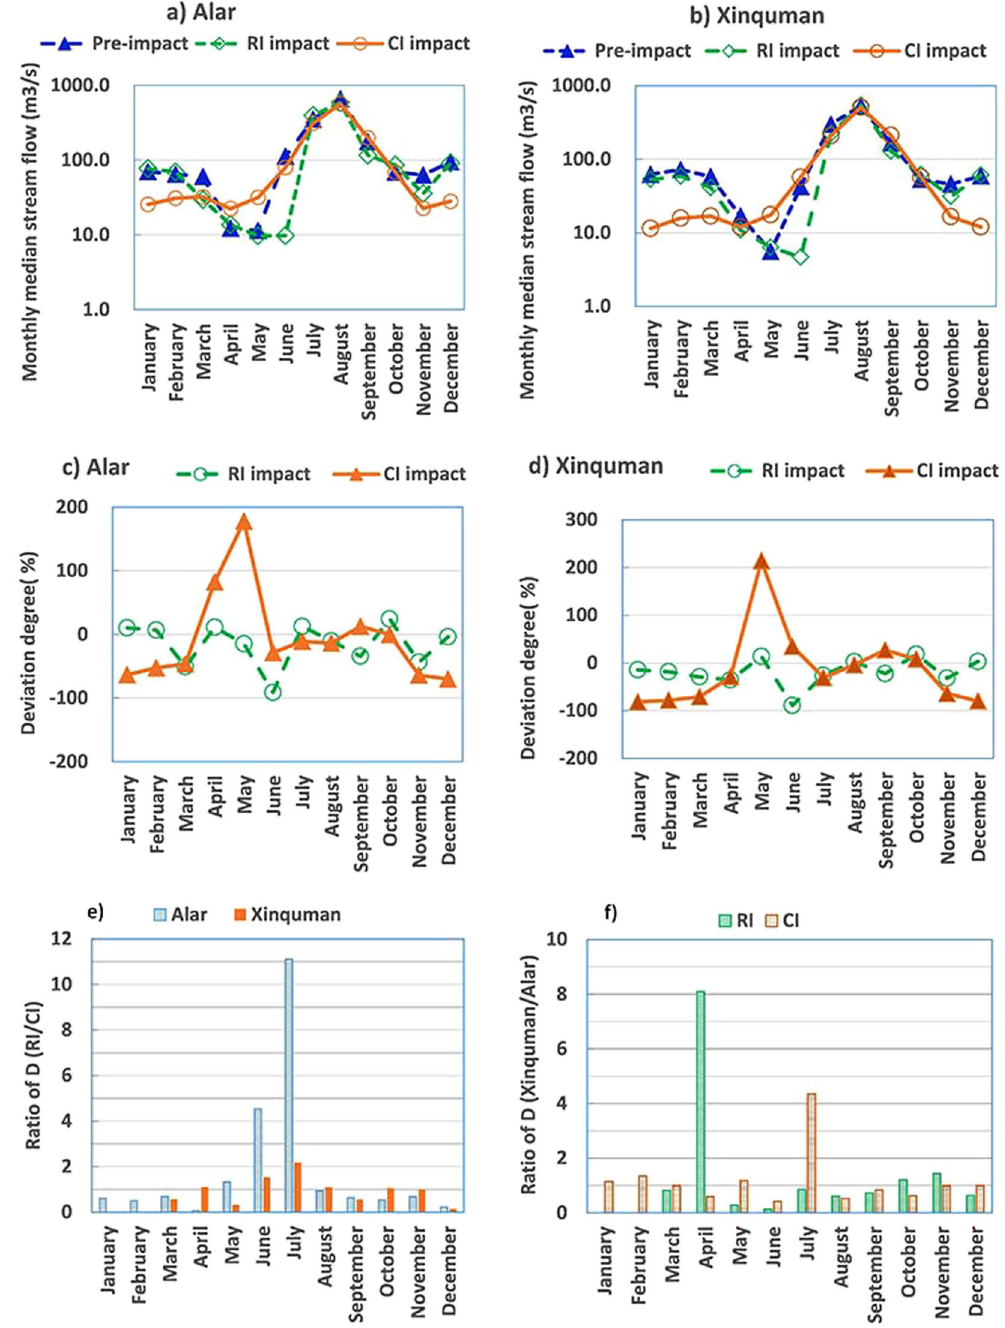
Figure 1. Plots of median monthly stream flow at ( a ) the Alar station and ( b ) at the Xinquman station, deviation degree of median monthly stream flow ( c ) at the Alar station and ( d ) at the Xinquman station, ratio of degree of hydraulic alteration ( e ) for the RI impact to the CI impact, and ( f ) between the two stations (note: RI for reservoir irrigation from 1973 to 1989 and CI for channel irrigation from 1995 to